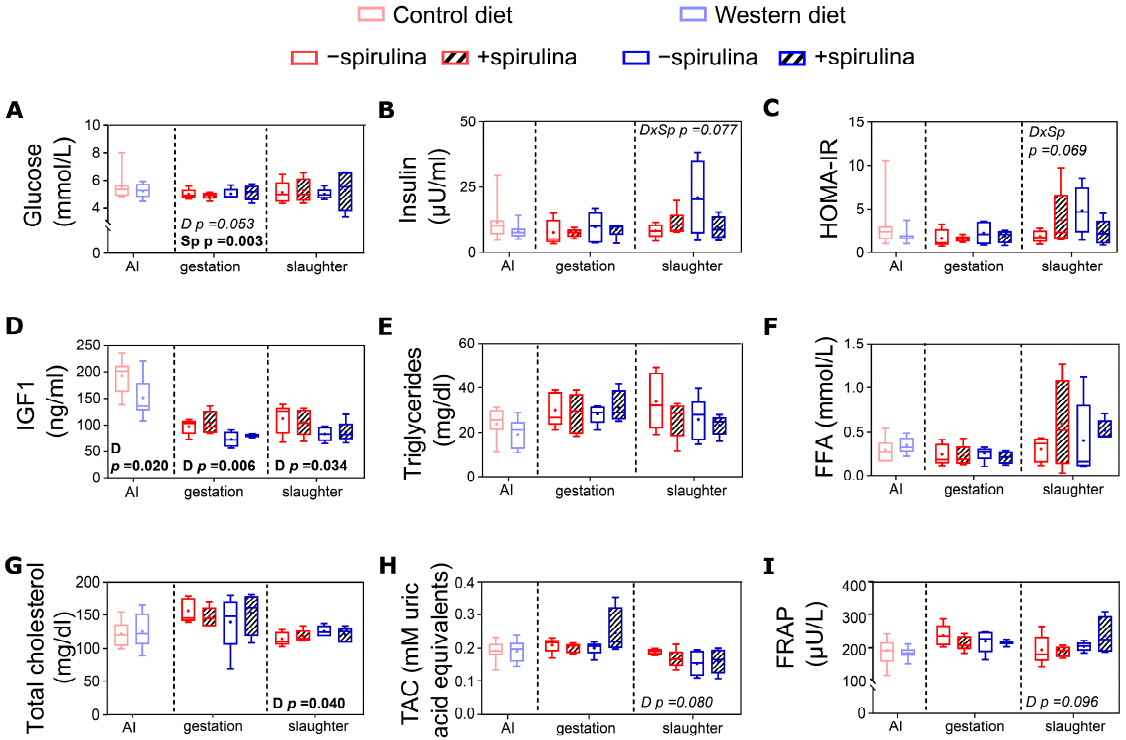
Figure 6. Systemic metabolic and oxidative stress markers of sows at artificial insemination (AI), 30 days before calculated farrowing (gestation), and 5 weeks post-lactation (slaughter). Concentrations of ( A ) serum glucose, ( B ) plasma insulin, ( C ) calculated index for insulin resistance (HOMA- IR), concentrations of ( D ) plasma IGF1, ( E ) plasma triglycerides, ( F) serum free fatty acids (FFA); ( G ) plasma total cholesterol, and ( H ) serum total antioxidant capacity (TAC) as well as ( I ) serum ferric reducing antioxidant power (FRAP). CTR: control diet; WES: Western diet; D: diet; Sp: spirulina. Data are presented in boxplots with Spear style whiskers (min to